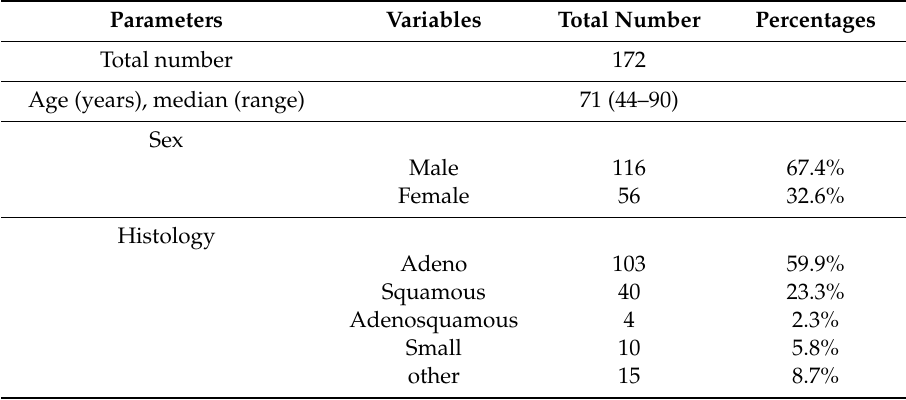
Table 1. Patient